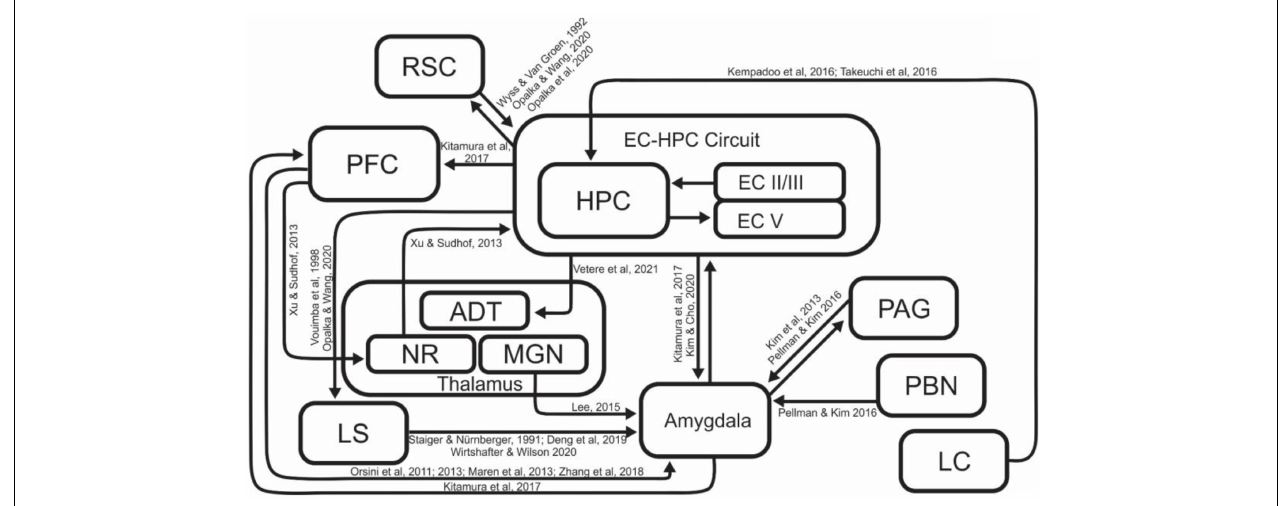
FIGURE 2 | A schematic diagram of the brain regions and related connections involved in contextual fear learning. While several regions feature more prominently than others in this process, a number of regions are involved in generating and refining contextual representations and associations. ADT, Anterodorsal Thalamus; EC, Entorhinal Cortex; HPC, Hippocampus; LC, Locus Coeruleus; LS, Lateral Septum; MGN, Medial Geniculate Nucleus; NR, Nucleus Reuniens; PAG, Periaqueductal gray; PBN, Parabrachial Nucleus; PFC, Prefrontal Cortex; RSC, Retrosplenial